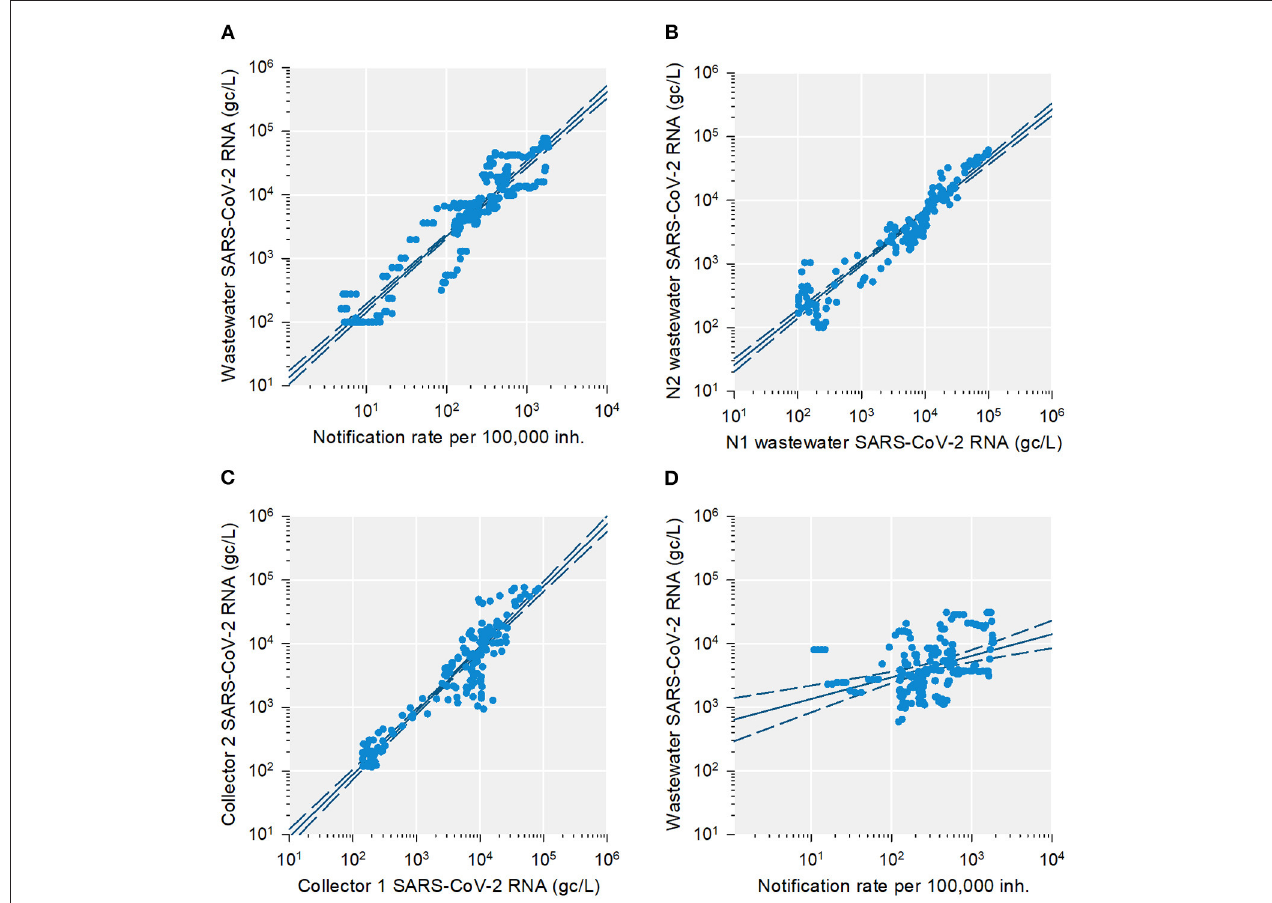
FIGURE 3 | Influence of wastewater sampling strategy on SARS-CoV-2 quantitation. Viral RNA concentrations in wastewater and cumulative case notification rates per 100,000 inhabitants were calculated for 14-day periods using a one-day shifted sliding windows. Least-squares log-log linear regression lines and 99% confidence intervals are shown. (A) Notification rate vs. median viral RNA concentration in wastewaters. (B) Average log viral RNA concentrations estimated using SARS-CoV-2 genome region N1 vs. N2. (C) Average log viral RNA concentrations estimated from the Pinedo WWTP collector 1 vs. collector 2. (D) Notification rate vs. average log viral RNA concentration in wastewaters using individual instead of composite samples.